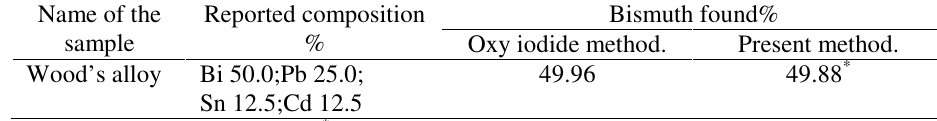
Table 2. Analysis of wood’s